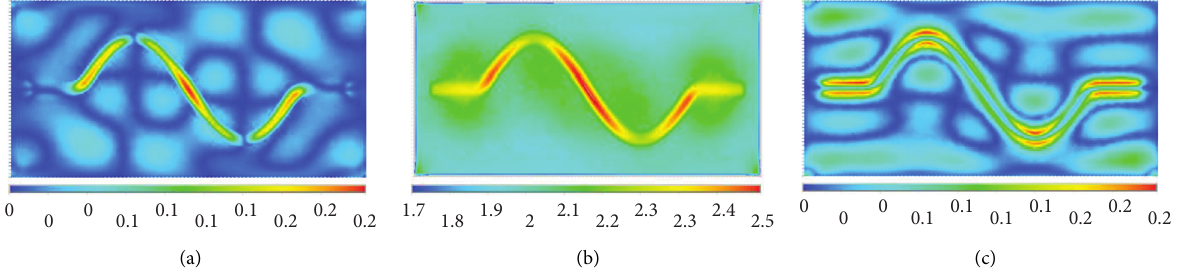
� 500m/s, and NR � 2). Top view displacement cloud view (a) u s